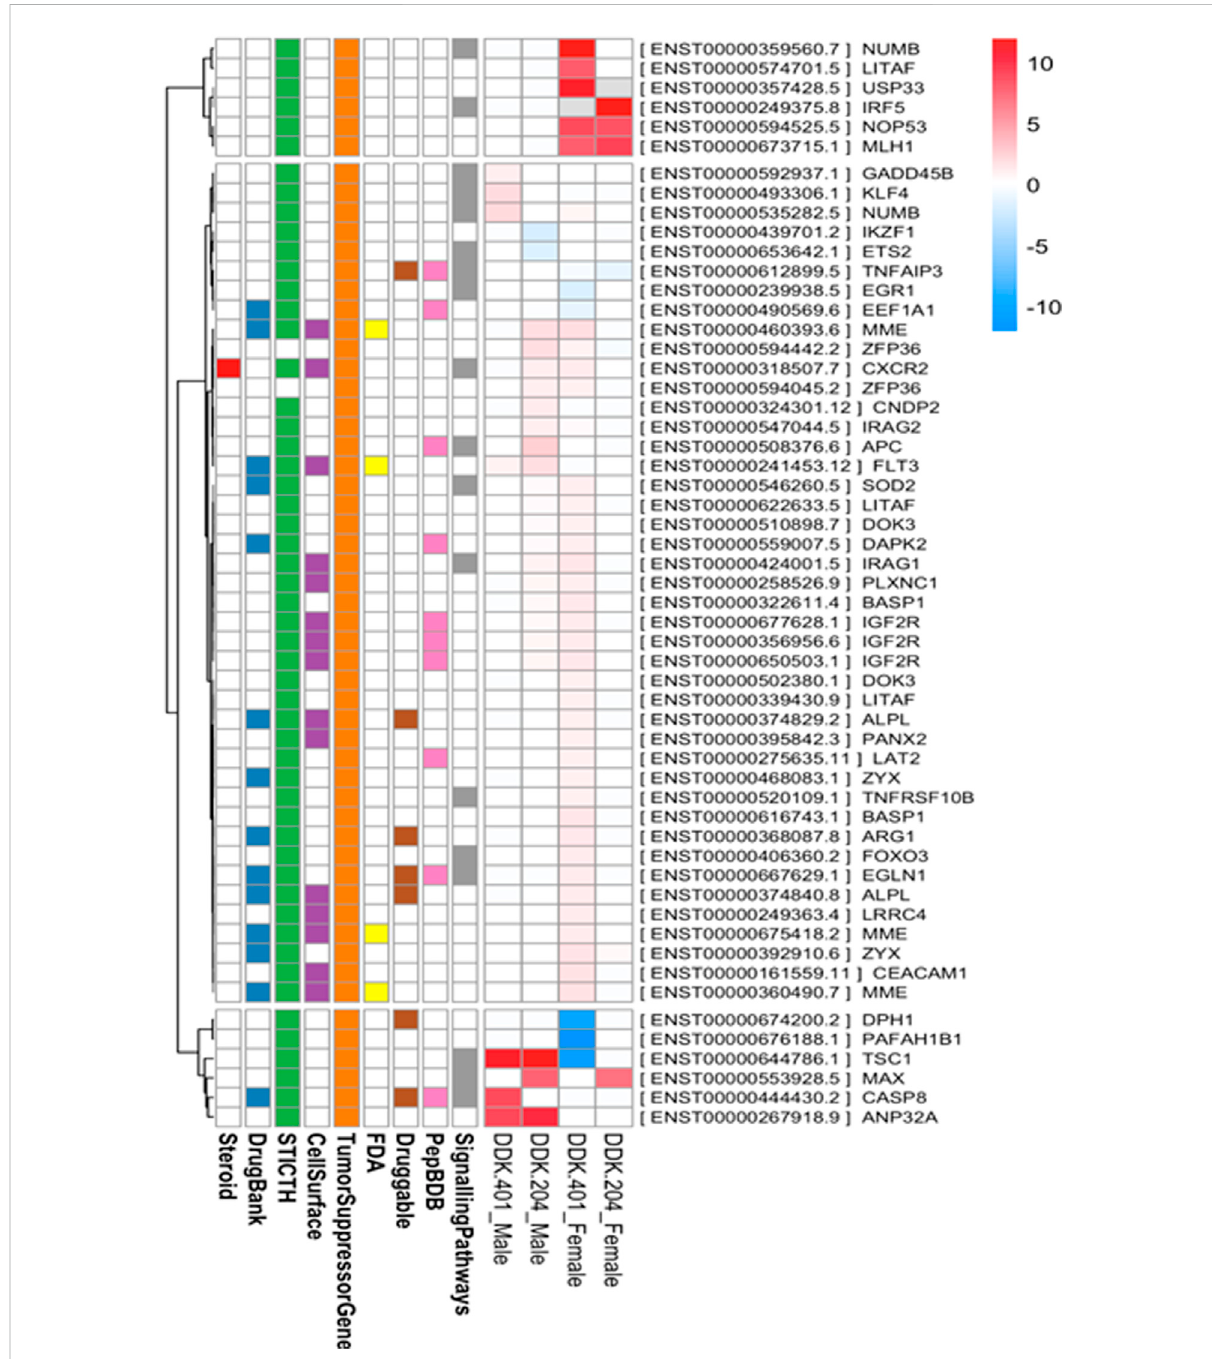
FIGURE 4 Transcripts belonging to the “ tumor suppressor genes ” category that were differentially expressed between the DDK-401 male and female groups and DDK-204 male and female groups displayed as a